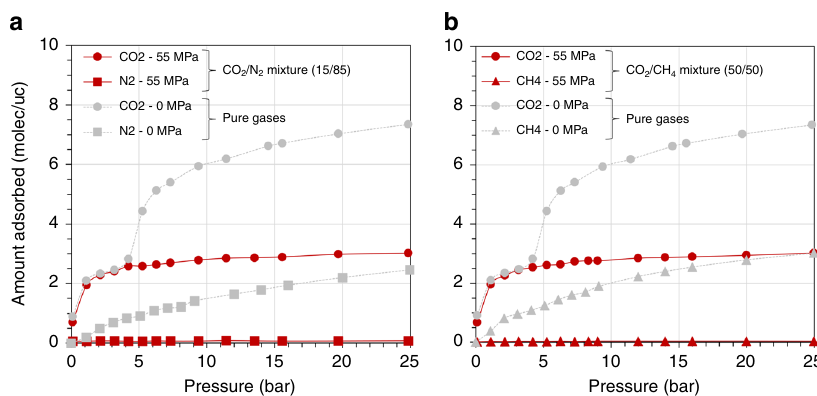
Fig. 3 Hybrid osmotic Monte Carlo (HOMC) simulations of binary mixtures in MIL-53(Cr). a , b Simulated isotherms at 298 K for a the binary mixture CO 2 /N 2 (15/85) under mechanical constraint (red circles — CO 2 ; red squares — N 2 ), and pure CO 2 (gray circles) and N 2 (gray squares) on the unconstrained MIL-53(Cr) and b the binary mixture CO 2 /CH 4 (50/50) under mechanical constraint (red circles — CO 2 ; red triangles — CH 4 ), and pure CO 2 (gray circles) and CH 4 (gray triangles) on the unconstrained MIL-53(Cr). Isotherms were obtained by using hybrid osmotic Monte Carlo simulations with an applied isostatic mechanical pressure of 0 and 55 MPa for the unconstrained and mechanically constrained MIL-53(Cr), respectively. The unit of the y -axis ‘ molec/uc ’ refers to molecules per unit